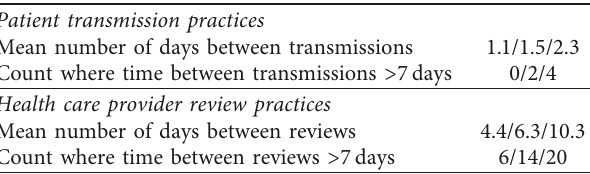
Table 2: Patient and health care provider’s sensor utilization